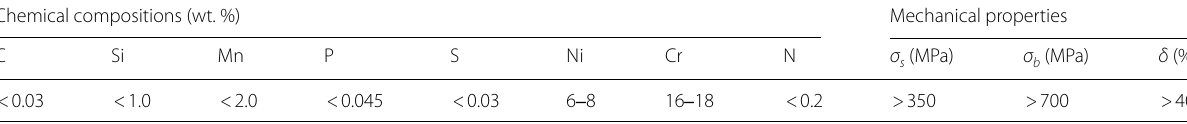
Table 1 Chemical compositions and mechanical properties of the experimental 301L plates Chemical compositions (wt. %)